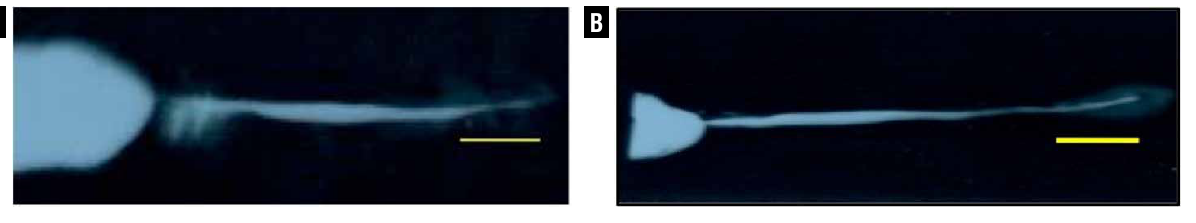
Figure 2 - A - Cystourethrography - Rabbit Group I (seeded heterologous matrix). Yellow line delimiting penile urethra subjected to matrix interposition. B - Cystourethrography Rabbit Group II (non-seeded heterologous matrix). Yellow line delimitating penile urethra subjected to matrix interposition.